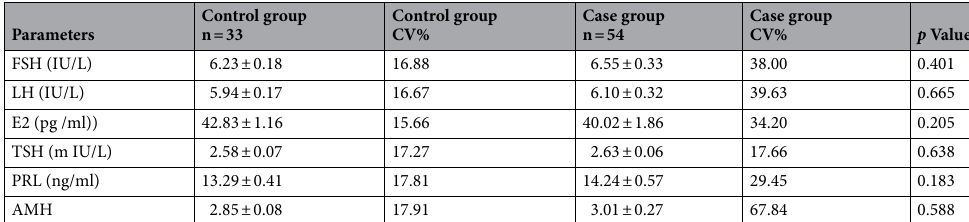
Table1. Comparison of serum hormonal evaluation in women undergoing ICSI in the case and control groups. Different parameters were compared between women in the case and the control groups who underwent ICSI. There were no significant differences in the case from the control group based on the T-test ( p > 0.05). Follicle stimulating hormone (FSH), luteinizing hormone (LH), estradiol (E2), thyroid-stimulating Hormone (TSH), prolactin (PRL), anti mullerian hormone (AMH), coefficient of variation (CV%). The results are presented as the mean ± SEM.